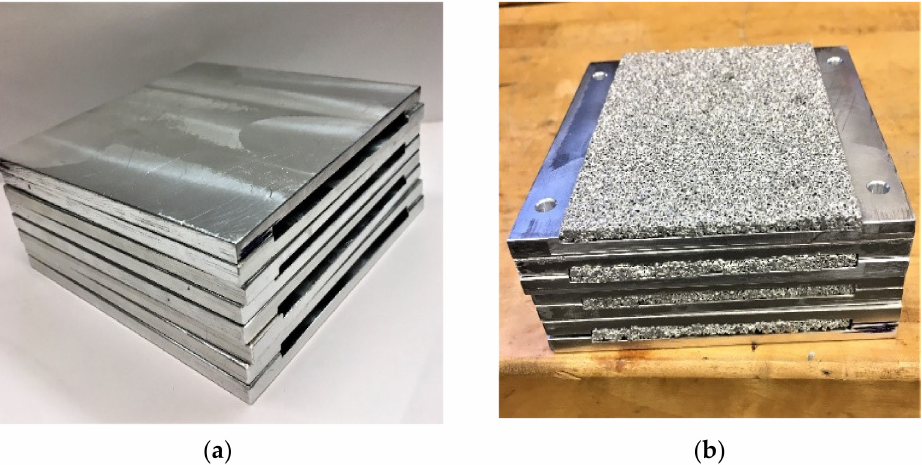
Figure 8. ( a ) Aluminum plates with open cooling channels representing bipolar plates in the commercial stack EFC-100-03- 6-ST, ( b ) cooling channels filled with aluminum foam; one channel uncovered to show metal